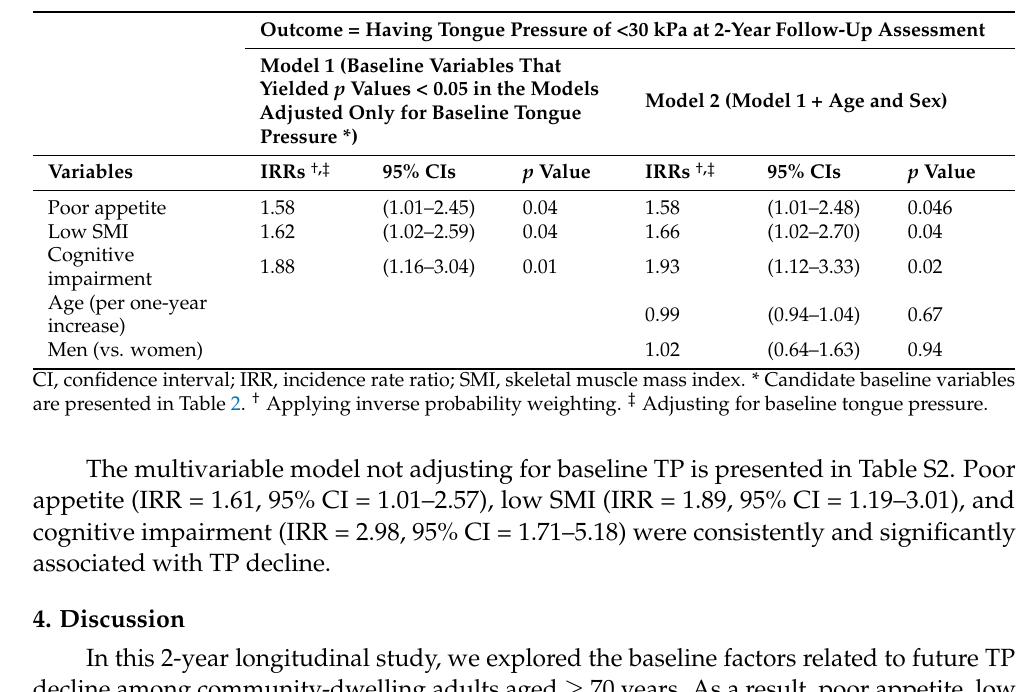
Table 3. Multivariable Poisson regression models for the factors related to tongue pressure decline. Outcome = Having Tongue Pressure of <30 kPa at 2-Year Follow-Up Assessment Model 1 (Baseline Variables That Yielded p Values < 0.05 in the Models Adjusted Only for Baseline Tongue Pressure *)